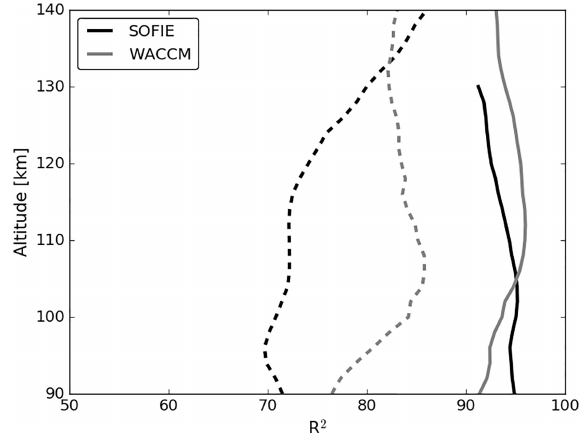
Figure 7. Percentage of the total variance in SOFIE (black) and WACCM (grey) data that can be explained by the seasonal clima- tology (dashed lines). Full lines represent the combined explained variance of the seasonal climatology and MLR model.